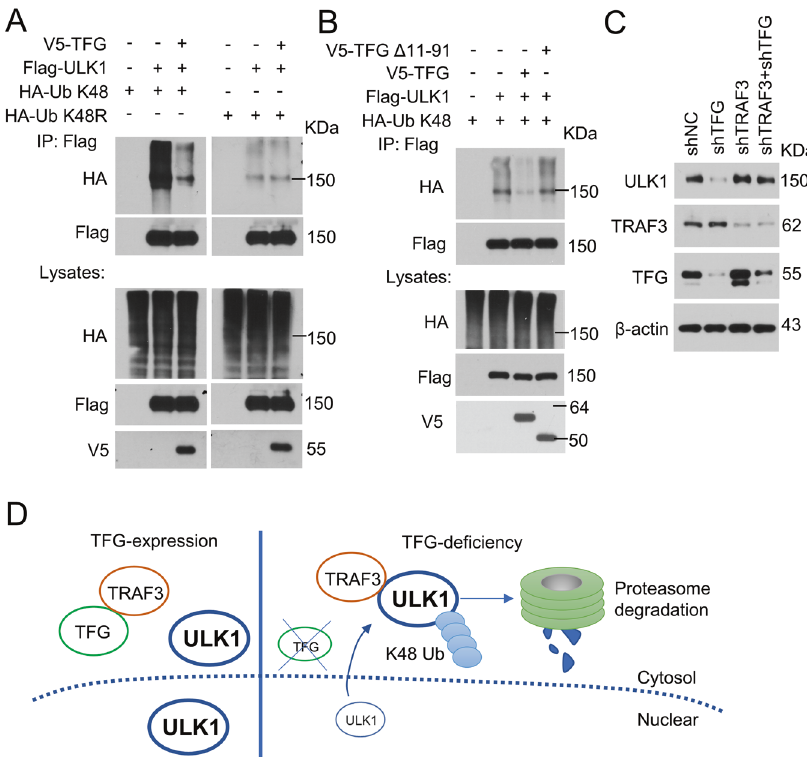
Fig. 6 TFG suppresses TRAF3-mediated ULK1 degradation. A Flag-ULK1 and V5-TFG were transfected into HEK293 cells together with HA- Ub-K48 or HA-Ub K48R as indicated. Flag-ULK1 was isolated by IP and subjected to IB assays using anti-HA and anti-Flag antibodies. Protein lysates were also subjected to direct IB (bottom panels). B Flag-ULK1 and HA-Ub K48 were transfected into HEK293 cells together with V5- tagged wild-type TFG or mutant TFG ( Δ 11 – 91, lacking TRAF3 binding domain). Flag-ULK1 were isolated by IP and subjected to IB using anti- HA and anti-Flag antibodies. Protein lysates were also subjected to direct IB (bottom panels). C THP-1 cells were transduced by shNC, shTFG, and/or shTRAF3. Total cell lysates were extracted and ULK1 protein level were analyzed by IB assay. D A proposed model of TFG